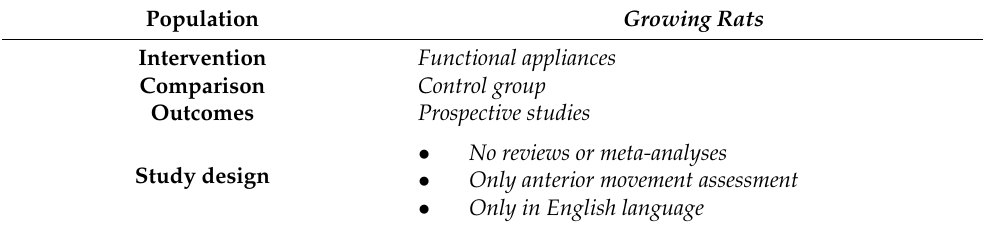
Table 1. Eligibility criteria according to